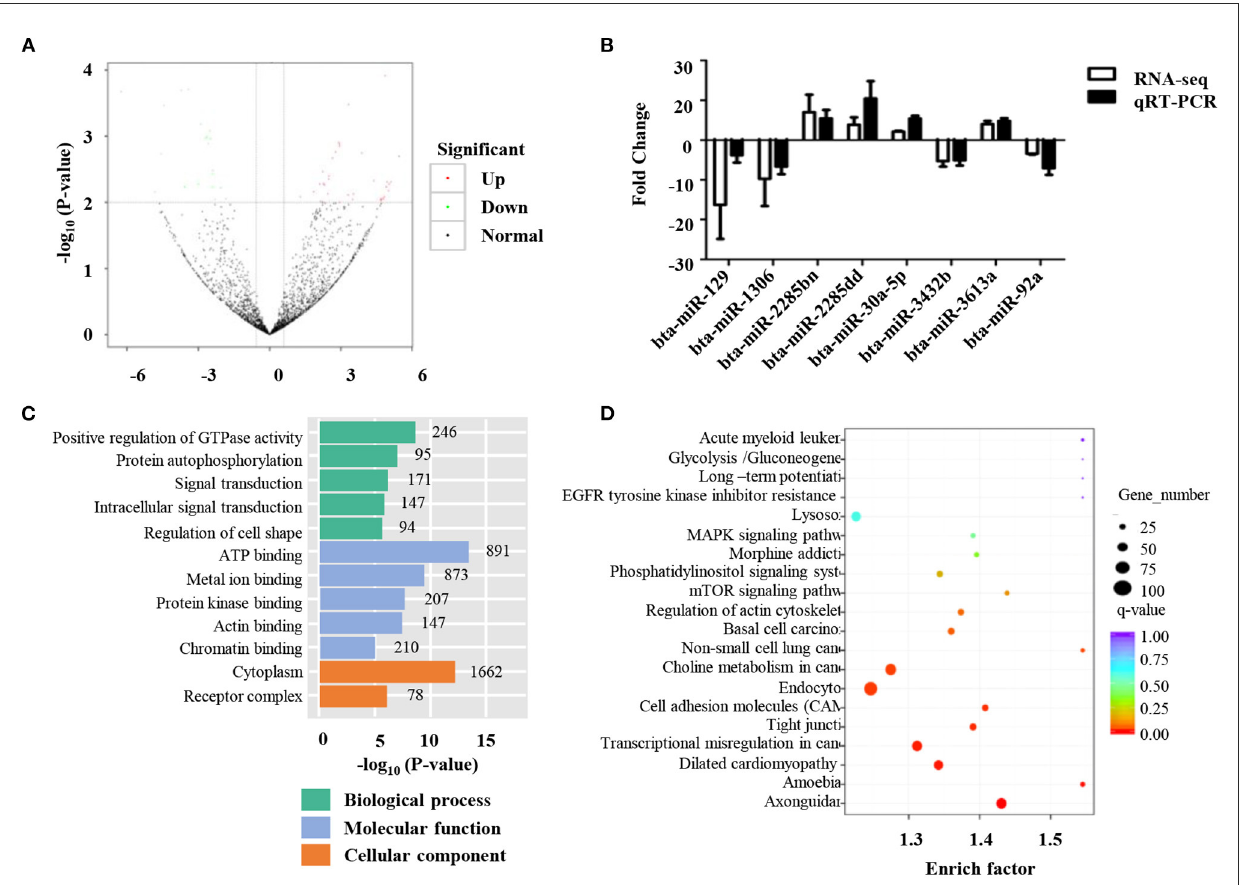
FIGURE3 Identification of differentially expressed miRNAs. (A) Volcano plots of the differential microRNA between normal and low-quality semen group; (B) The qRT-PCR validation of eight differential microRNAs; (C) Gene ontology (GO) analysis of the predicted target genes regulated by the differentially ex-pressed miRNAs. (D) Kyoto Encyclopedia of Genes and Genomes (KEGG) pathway analysis of the predicted target genes regulated by the differentially expressed